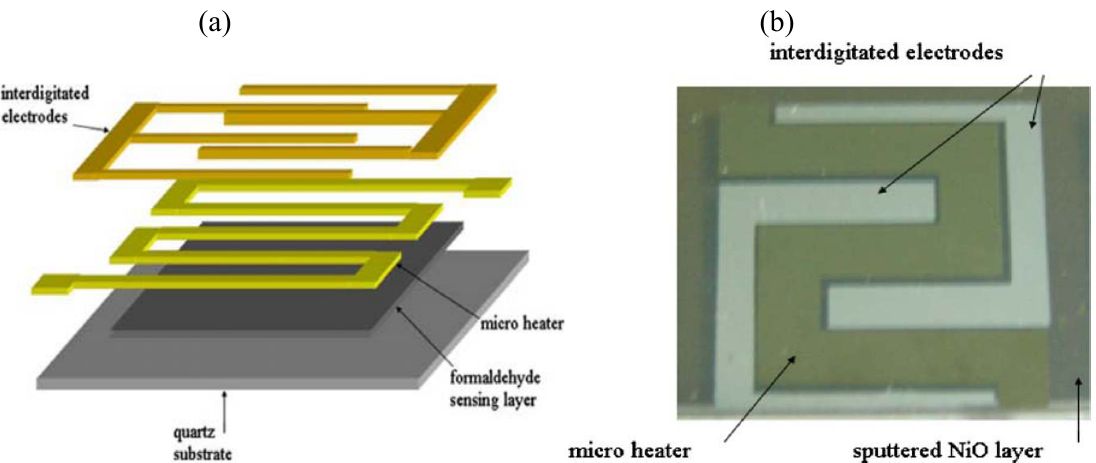
Figure 2. Formaldehyde sensor with integrated Pt micro-heater and Au interdigitated electrodes on a sputtered NiO layer, reprinted from [42] with the permission of Springer Science + Business